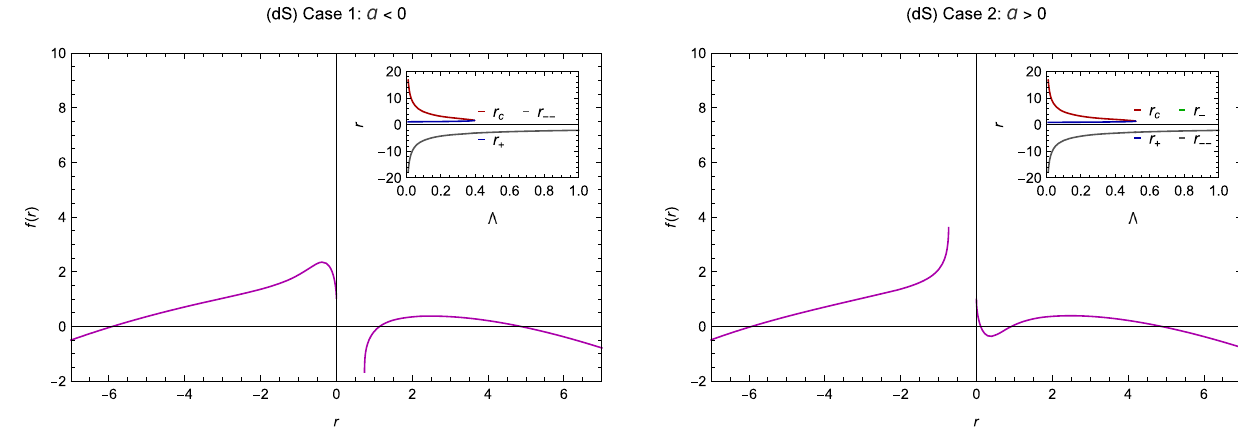
Fig. 1 The metric function f ( r ) for a = − 0 . 20 (left) and a = 0 . 20 (right); (cid:2) = 0 . 1, M = 1 /